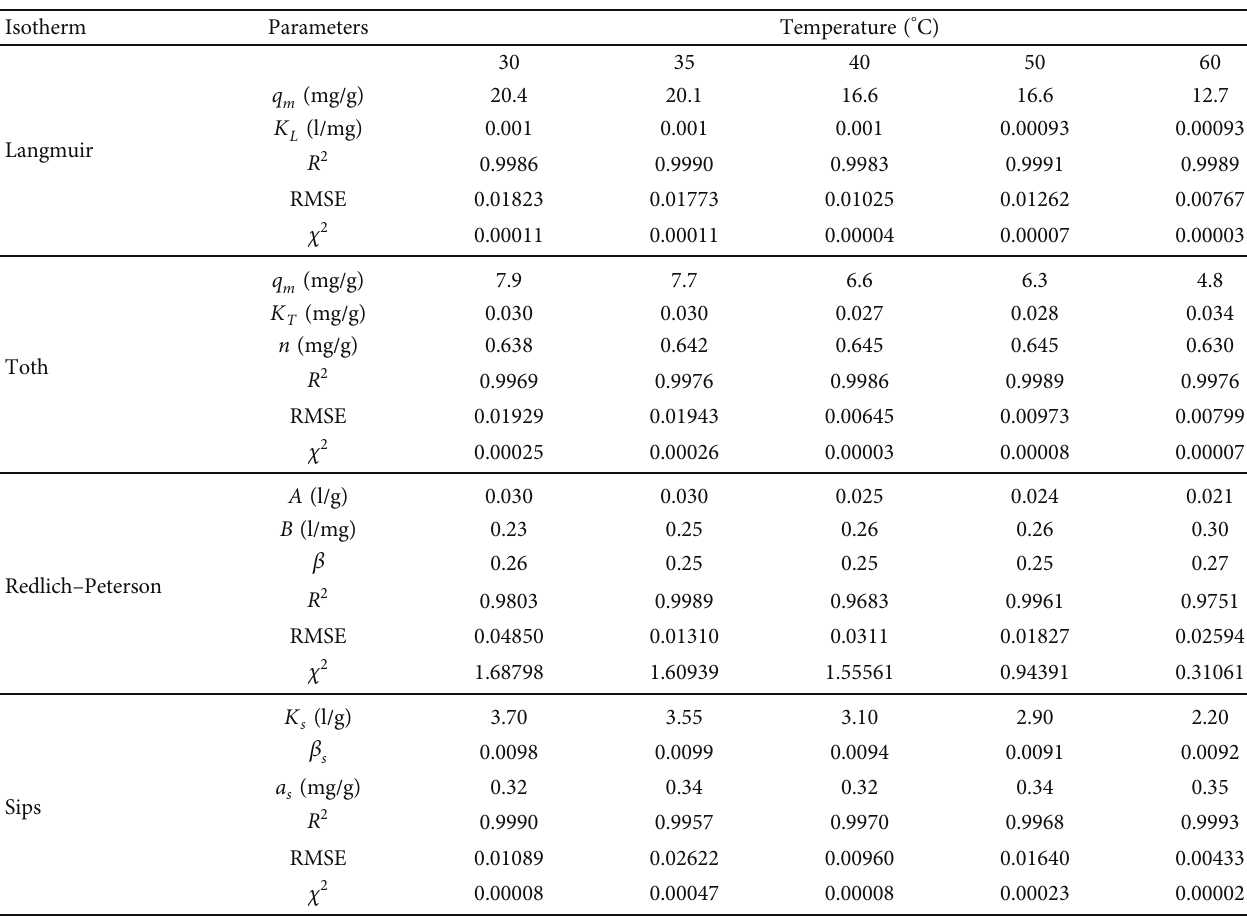
Table 2: Isotherm parameters for the uptake of phenol onto TMCC.